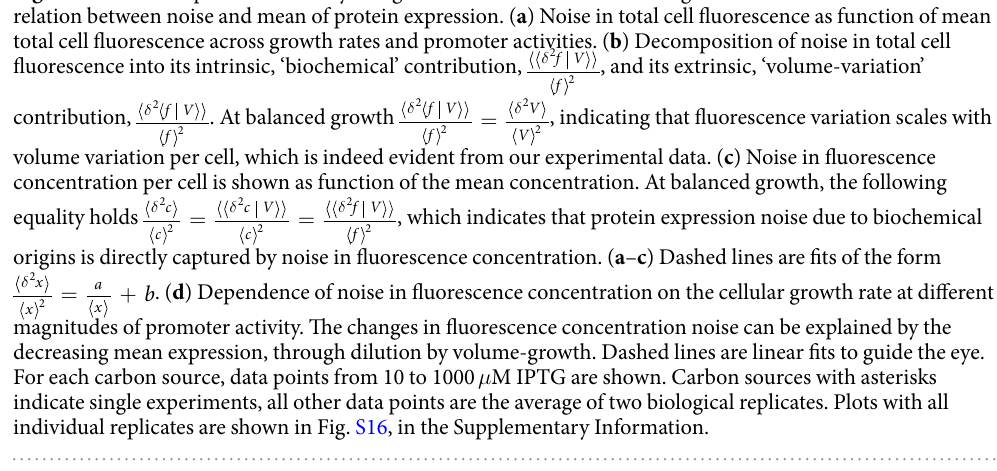
(those are the dashed lines in Fig. 4b). In principle, transcription or translation bursts can occur, contributing to the a or b values, but we cannot decide from our data whether this is the case; this would require knowledge of the true total-cell protein copy number rather than total-cell protein fluorescence. The extrinsic noise term equals volume noise at balanced growth (see the Supplementary Information). It is determined by cellular heterogeneity in volume. It results from differences in cell cycle progression (cells double their volume on average during a cell cycle), asymmetric division of mother cells, variability in interdivision times, noise in cellular growth rate as function of the cell cycle and other processes. The extrinsic noise term is independent of the mean total cell fluorescence (Fig. 4b), indicating that cell volume noise is hardly changing across growth conditions and promoter activity. This is likely explained by the constant variation in cell volume from birth to division (a factor 2), a constant noise of mother and daughter volumes, and a constant dependency of mean cell volume on cell-age (cell-cycle progression) 20 . According to us, intrinsic noise in fluorescence concentration is an informative measure about functional heterogeneity in isogenic cells. Since cells with the same protein concentration will experience the same biochem- ical influence of this protein. Those cells are therefore identical with respect to the functional, or physiological, consequences of this protein. Noise in protein concentration is therefore very informative about the functional noise across isogenic cells. At balanced growth, noise in fluorescence concentration, intrinsic noise in total cell fluorescence and fluores- cence concentration are all identical in value (see Supplementary Information).